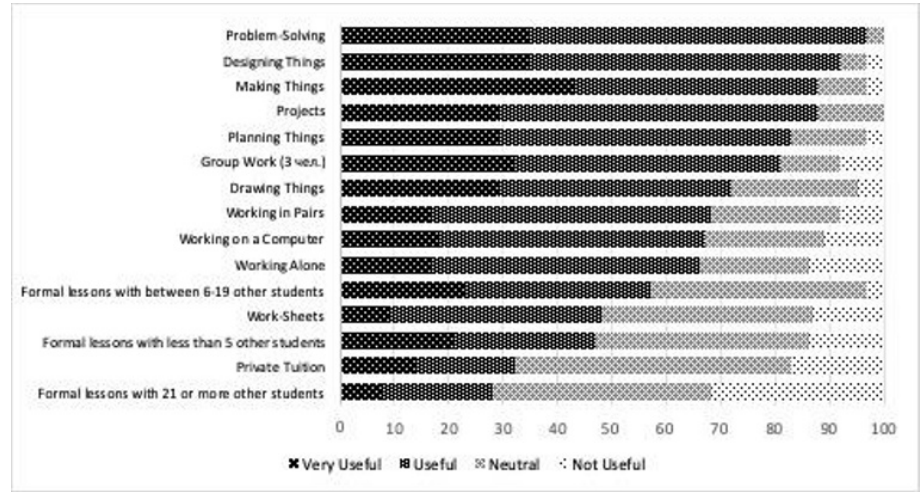
Fig. 1. Student perceptions of the usefulness of previous learning experiences (%).